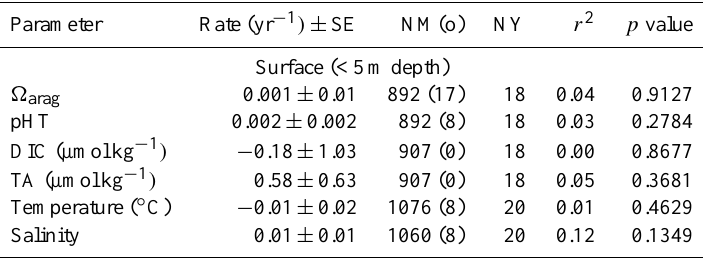
Table 2. Mean annual trend (1993–2012) of Palmer-Long Term Ecological Research (PAL-LTER) surface (depth <5m) carbonate chemistry and hydrography from the West Antarctic Peninsula (central subregion). Regression statistics include the mean annual rate (yr − 1 ) , standard error (SE), number of measurements (NM), number of years (NY), r -squared, and p value for aragonite saturation state ( (cid:127) arag ) , pHT, dissolved inorganic carbon (DIC, µmolkg − 1 ) , total alkalinity (TA, µmolkg − 1 ) , temperature ( ◦ C), and salinity. Trends with a p value <0.05 would be considered statistically significant at the 95% confidence level. Points that were outliers at 95% probability level were excluded (o). Parameter Rate (yr − 1 ) ± SE NM(o)